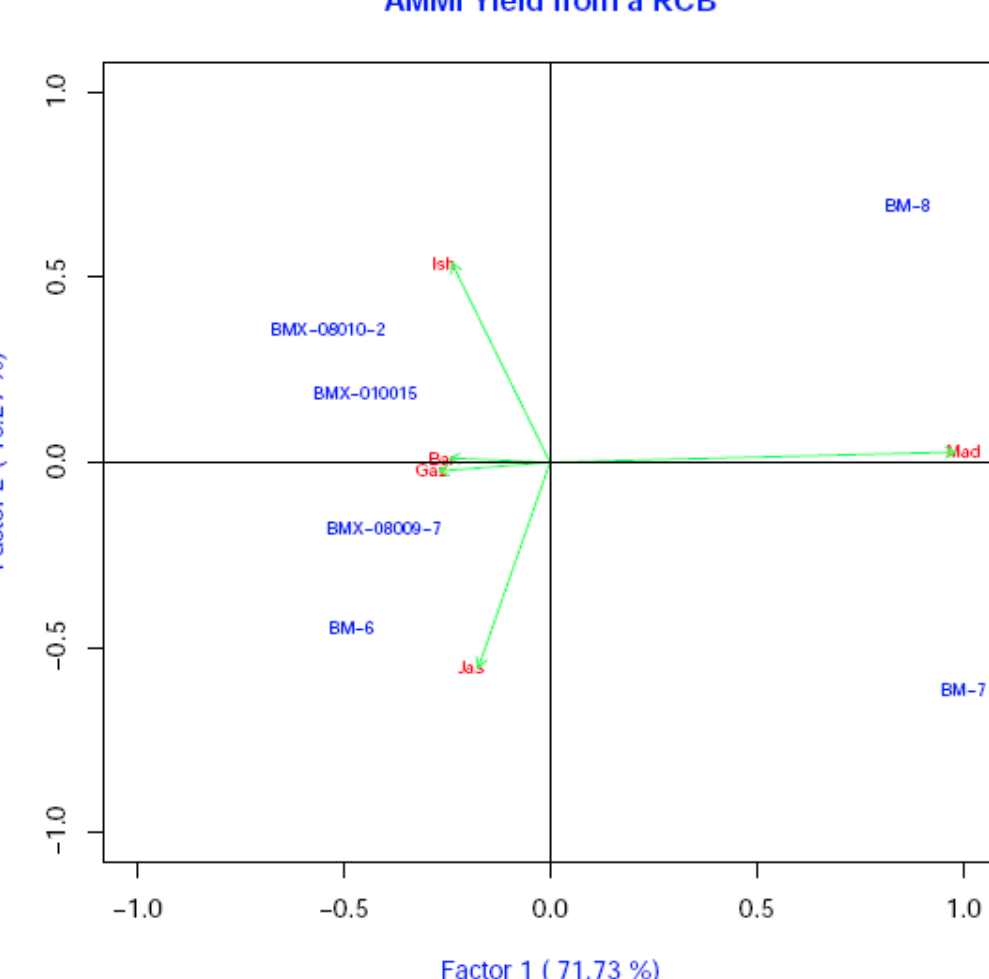
Figure 3. AMMI 2 biplot displaying AMMI PCA II against AMMI PCA I. The genotypes BM-6, BM-7, and BM-8, stands for BARI Mung-6, BARI Mung-7, and BARI Mung-8, respectively, and the environments Ish, Gaz, Jas, Bar, and Mad stands for Ishurdi, Gazipur, Jashore, Barishaland Madaripur, respectively.